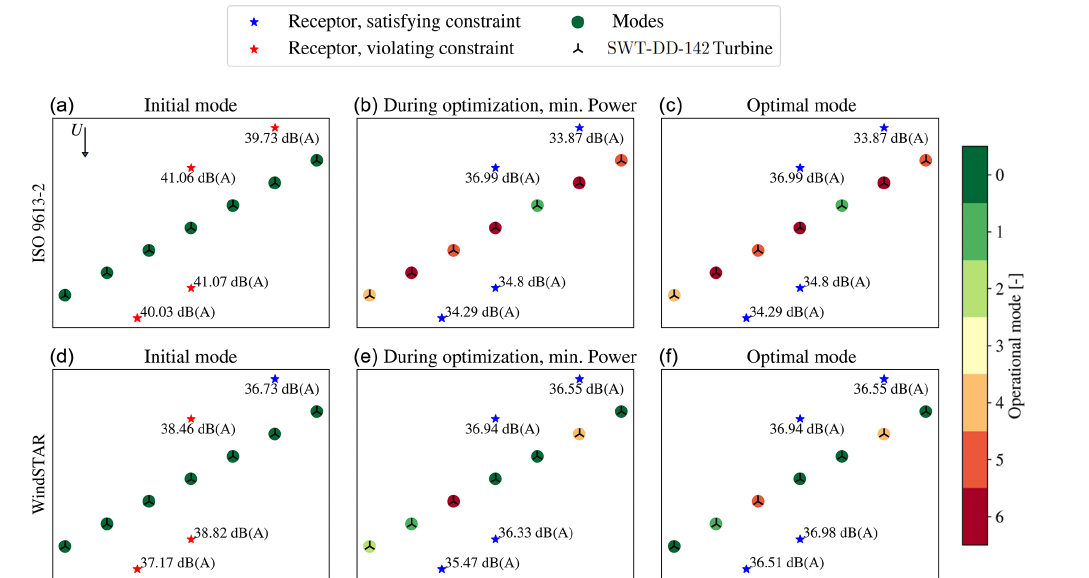
Figure 11. Scatter plots of the operational modes of the seven SWT-DD-142 wind turbines before (a, d) , at the minimum power iteration during (b, e) and after (c, f) the optimization at θ = 0 ◦ and U 0 = 10ms − 1 . The noise constraint is set to L p , lim ,j =